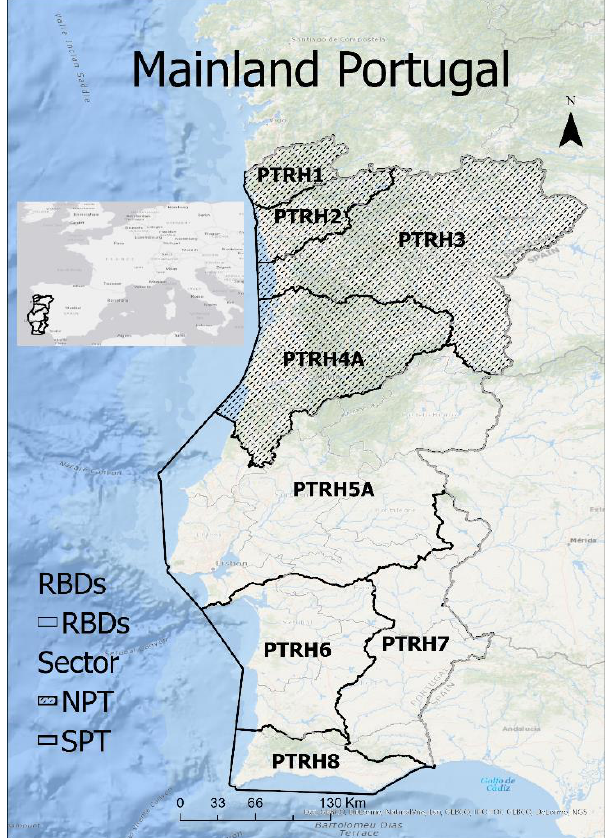
Figure 1. Overview of Portugal’s River Basin Districts organized by sector NPT (North of Portugal) and SPT (North of Portugal).